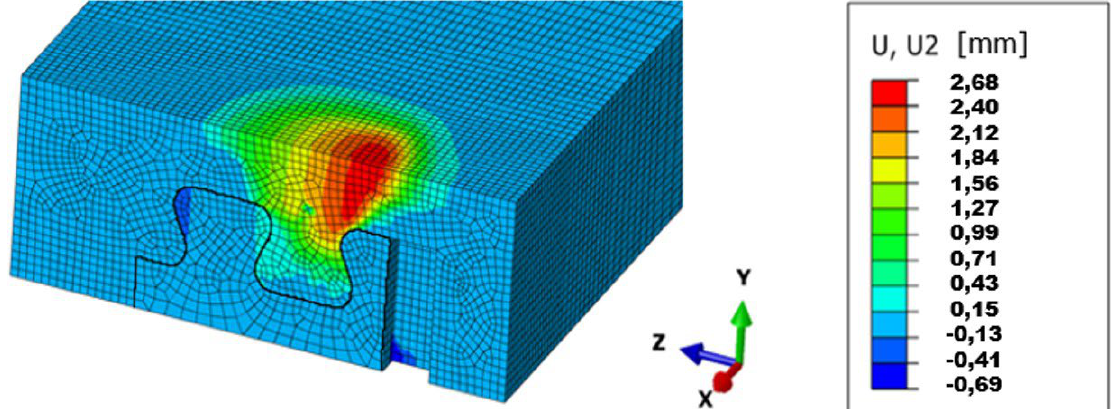
Figure 24. Vertical displacement of concrete due to pry-out.